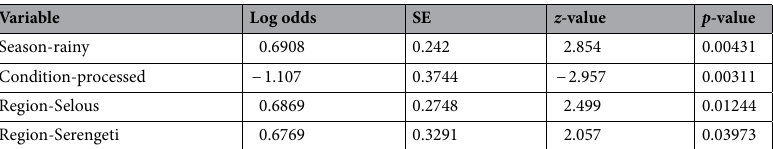
Variable Log odds